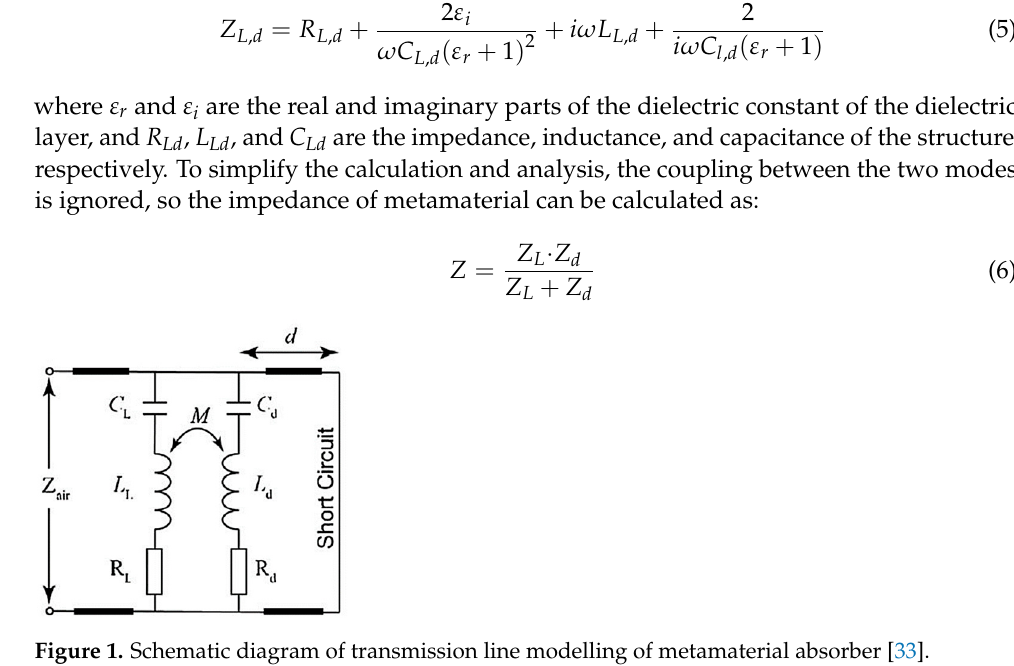
Figure 1. Schematic diagram of transmission line modelling of metamaterial absorber [33].